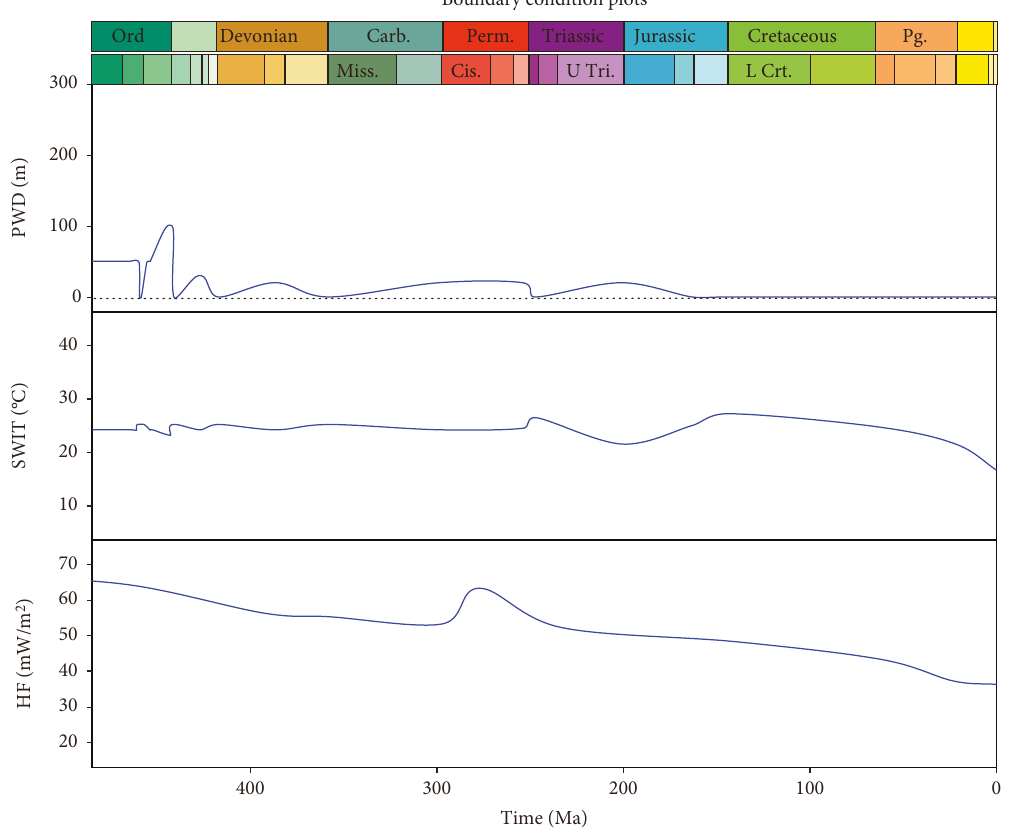
Figure 3: The boundary condition plots for Well ZG7-5. Table 4: Comparison between simulated and measured features of the fl